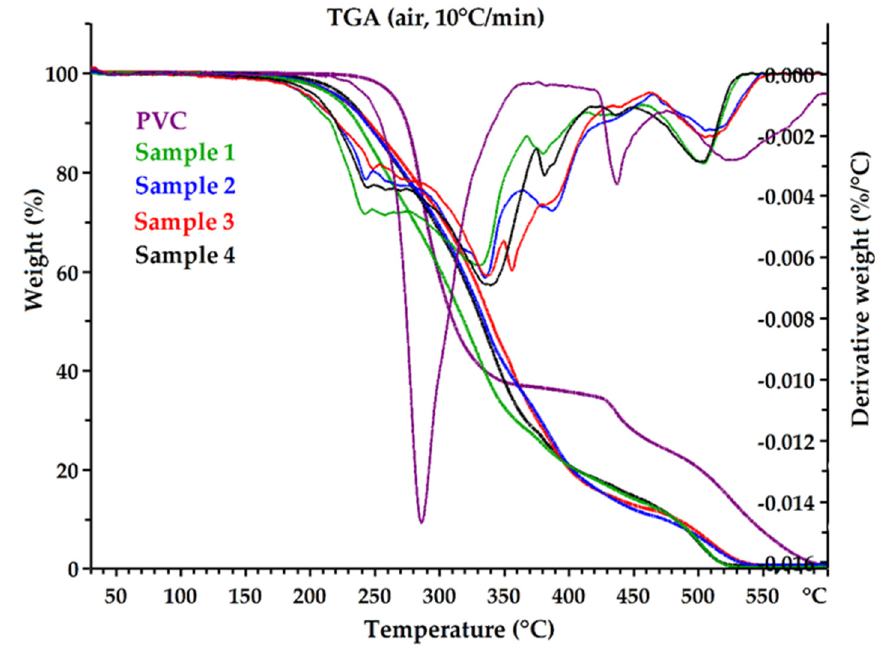
Figure 7. The TG and DTG curves of epoxidized mixed esters (Samples 1–4) and pure PVC in air.